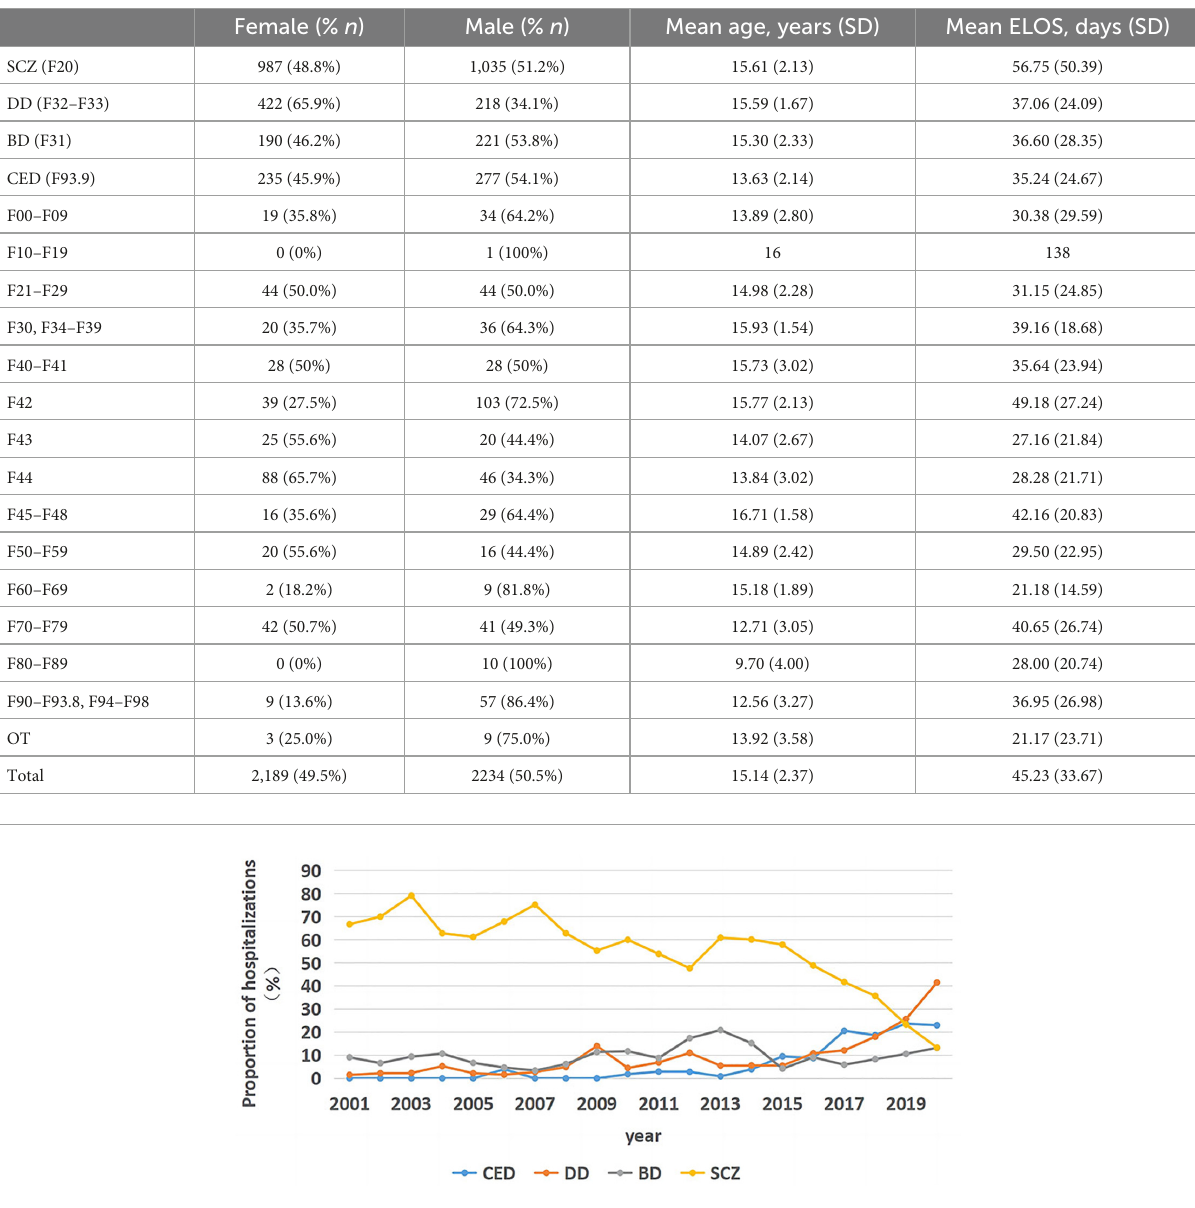
FIGURE1 Trends in hospitalization rates for the four major diseases from January 2001 to December 2020.